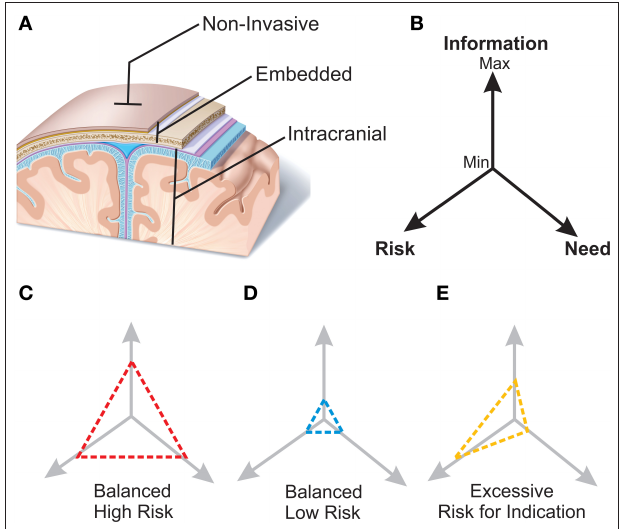
FIGURE 2 | Proposed terminology for BCI systems and schematic of matching the device with the indication. (A) Non-invasive. BCI systems, such as EEG and optical based approaches, that may touch the surface of the body but do not require penetration of the skin. No surgical procedure is required. Embedded . BCI systems that generally require a surgical procedure for placement, but do not enter the intracranial space. These include devices that are within the scalp, beneath the galea, or within the skull (but not through the inner table). Intracranial . BCI systems that are intracranial in location and generally require a surgical procedure for placement. These include ECoG, multi-electrode arrays, neural dust, and intravascular electrode systems. (B) The three driving factors that influence a BCI application are clinical need, clinical risk of the device, and neurologic information necessary to support the BCI solution. Various clinical scenarios have distinct informational demands and risk tolerance. (C) Represents “high need—high risk” clinical indication, such as a quadriplegic patient, who has a substantial clinical need for neural restoration to improve his/her quality of life and a higher risk can be tolerated ethically. (D) Represents “low need—low risk” scenario where a neural interface is used for cognitive augmentation but given the low clinical need would require a lower risk to be ethically feasible. (E) Imbalanced scenario where information and risk are excessive to clinical need of the